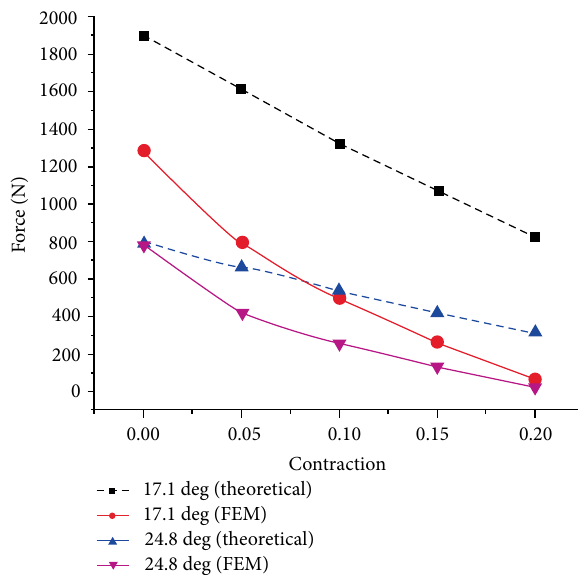
Figure 9: Static force-contraction relationship of PAMs with two initial braid angles of 17.1 degree and 24.8 degree under the pressure of 0.3 MPa.